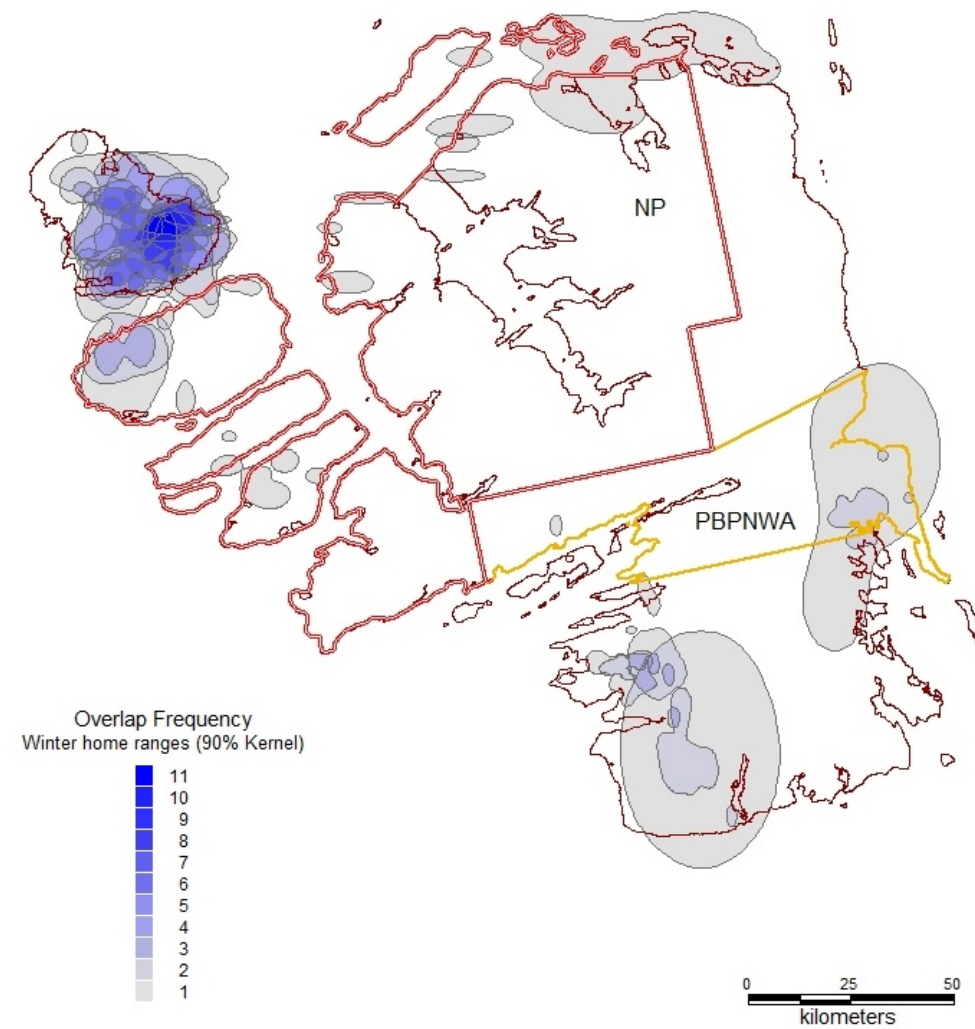
Figure 4. Winter individual female Peary caribou ranges for 2003–06 (unpubl. GN